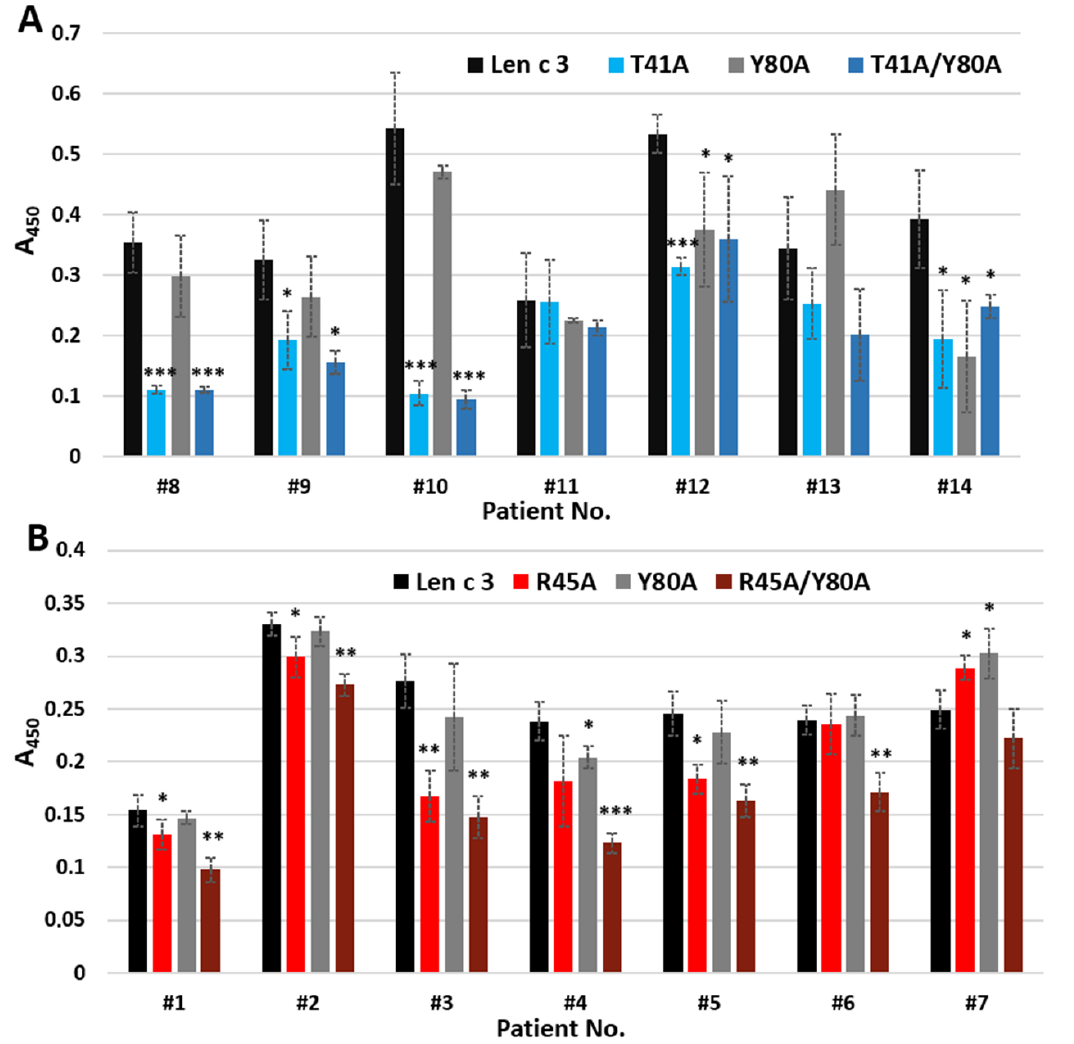
Figure 6. ELISA with Len c 3 and its mutant analogues using the patient sera containing sIgE to this allergen. ( A ) Comparison between Len c 3 and its mutant analogues T41A, Y80A and T41A/Y80A. ( B ) Comparison between Len c 3 and its mutant analogues R45A, Y80A and R45A/Y80A. Error bars represent standard deviation between technical replications. Differences in mean A values between Len c 3 and its mutant analogues for each patient were compared by t -test. Significance levels are: * p < 0.05; ** p < 0.01; *** p < 0.005.